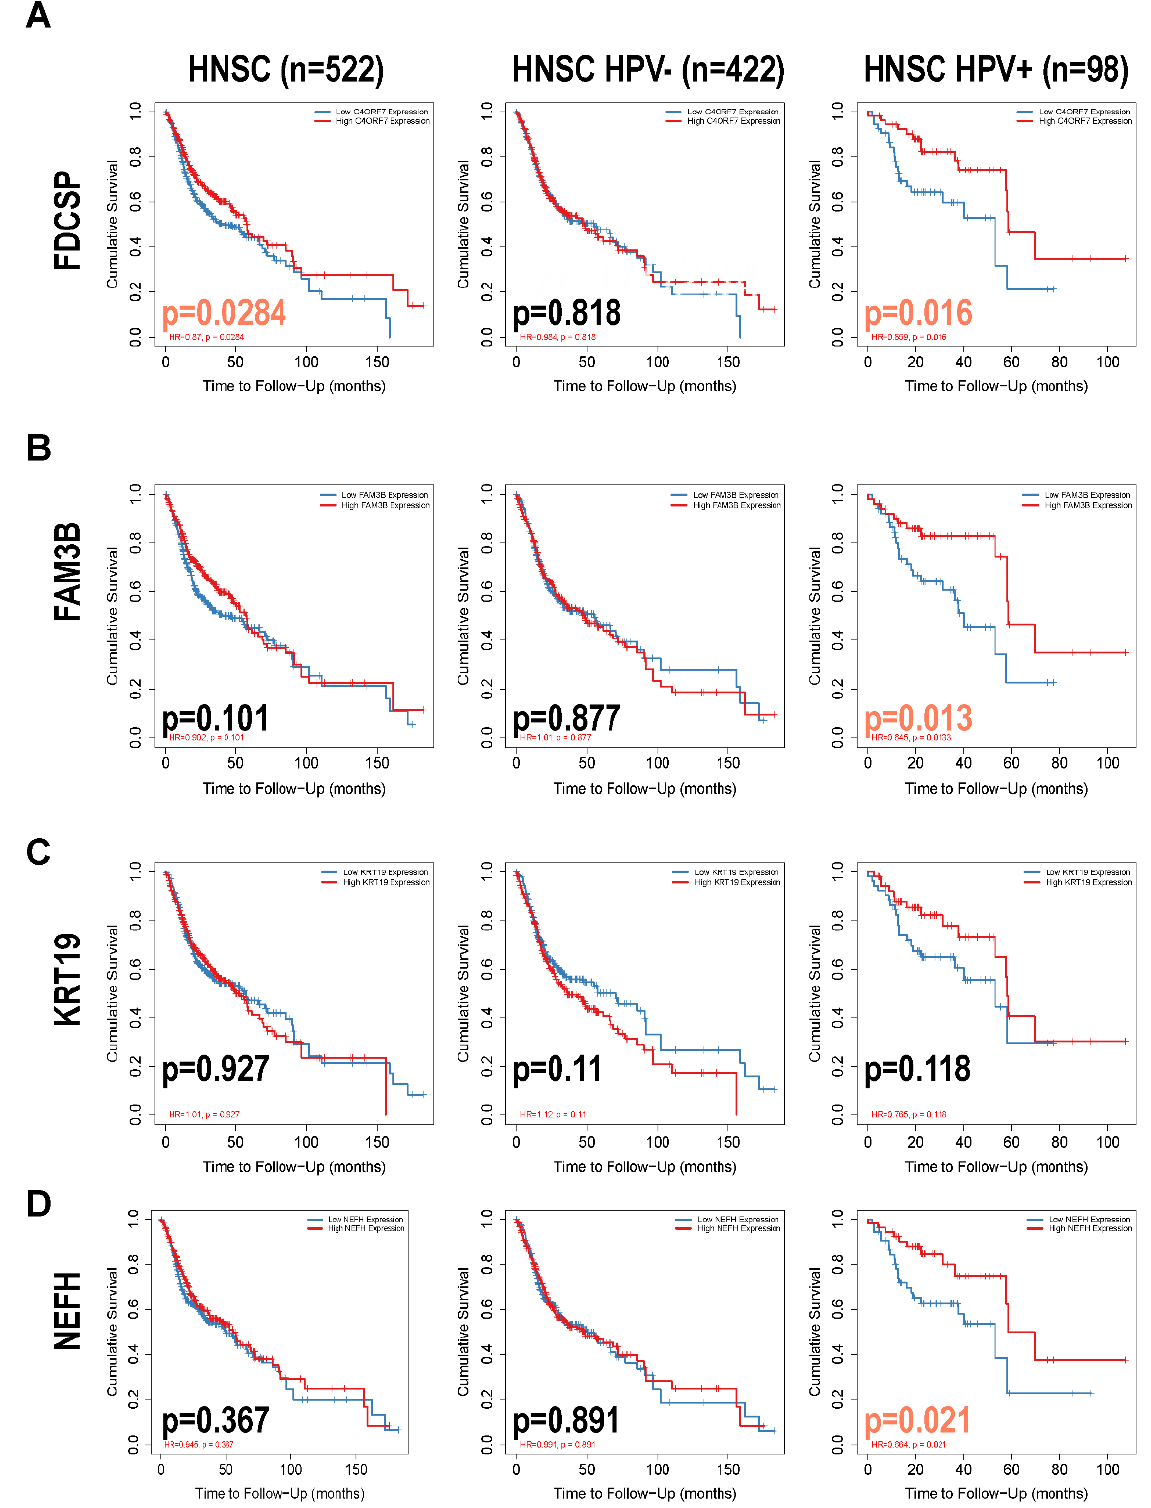
Figure 2. Overall survival analysis of DEGs in HPV status in HNSC. ( A – D ): Kaplan–Meier curves associated with upregulated differential genes (FDCSP, FAM3B, KRT19, NEFH) grouped by HPV status.